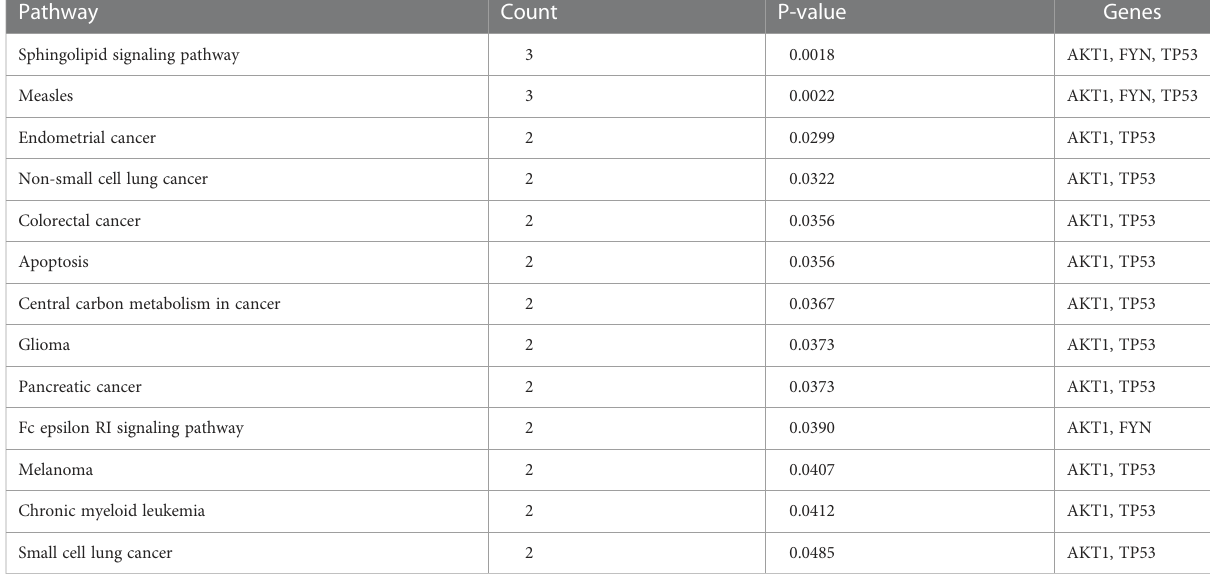
TABLE 5 13 KEGG